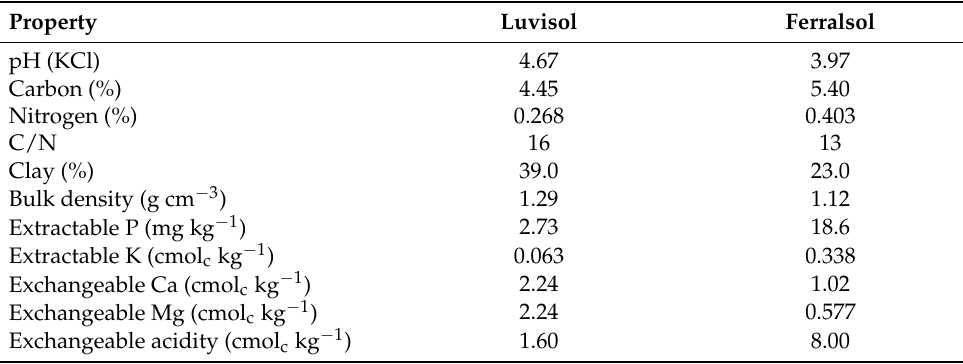
Table 1. Selected physico-chemical properties of the soils used in the study. Property